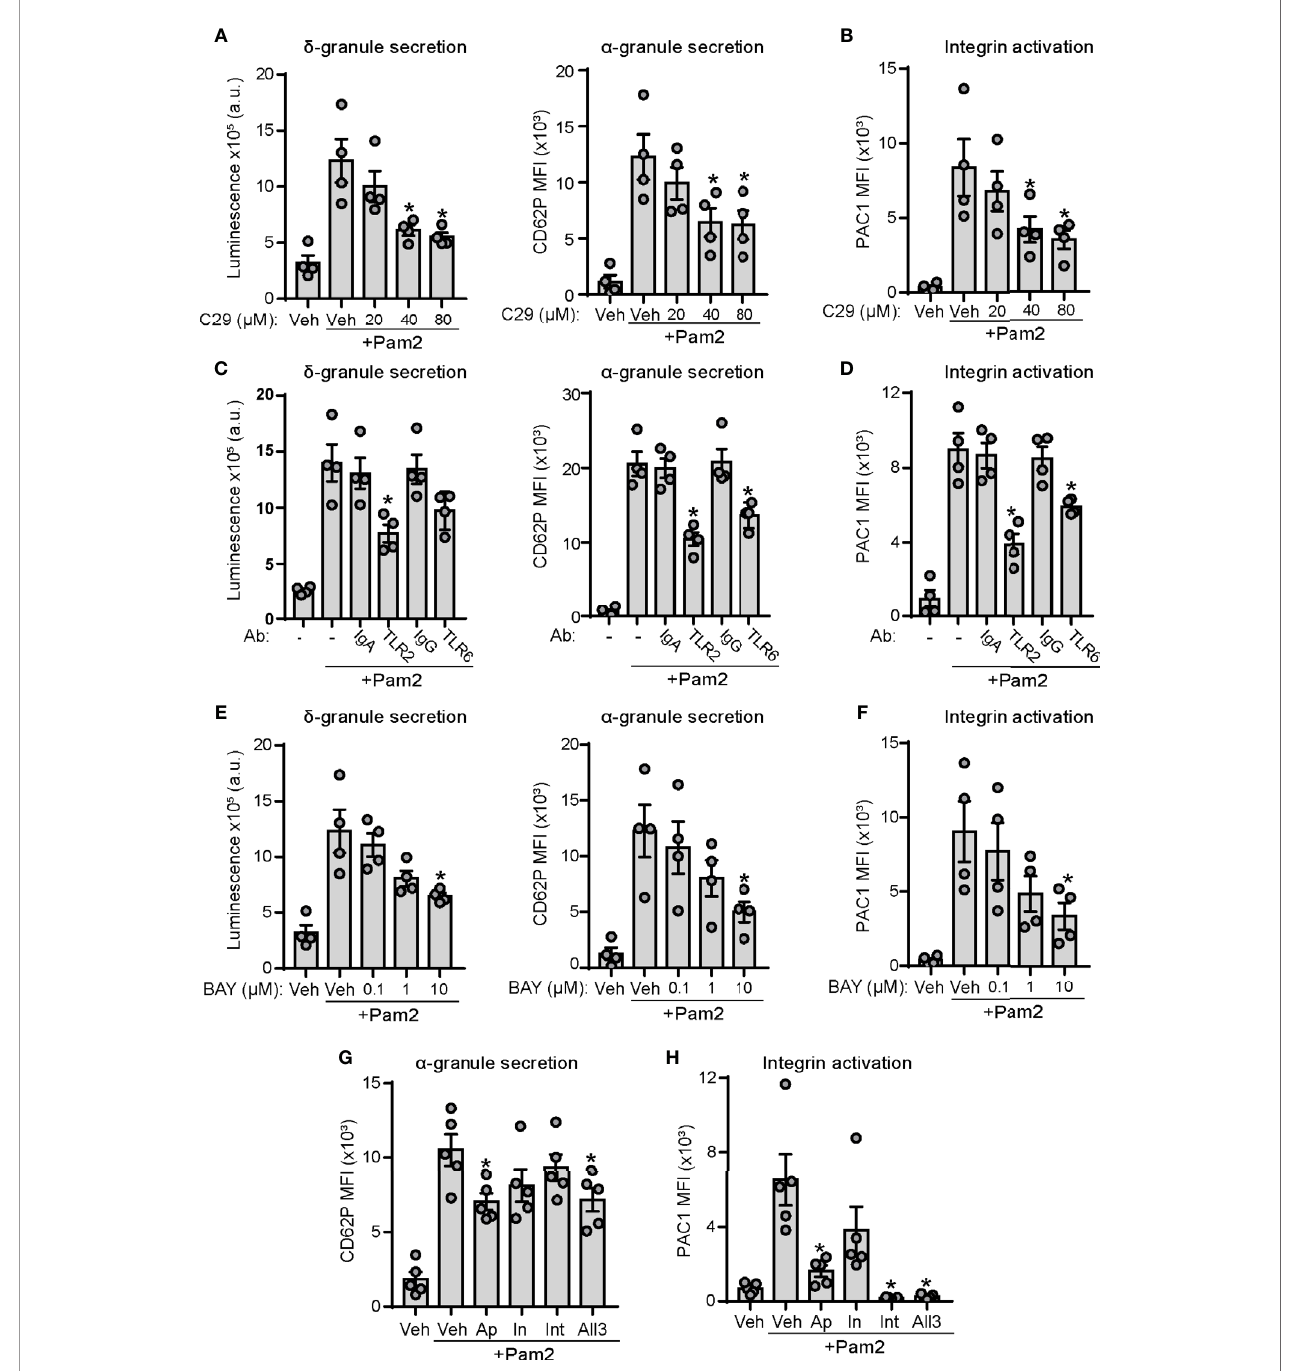
FIGURE 3 | TLR2/TLR6/NF- k B axis and an ADP-positive feedback loop play a role in Pam2CSK4-induced platelet function. (A – H) Washed human platelets were preincubated with the indicated blocking antibodies (25 µg/ml; 30 min), inhibitors or vehicle (10 min) at 37°C before activation with Pam2CSK4 (10µg/ml) and analysis of platelet granule secretion and integrin activation. (A, C, E) Platelets (2×10 8 /ml) were incubated with a luciferin luciferase reagent to measure ATP release and dense granule secretion. Data are expressed as raw mean luminescence (a.u.); n=4 experiments. (B, D, F – H) Platelets (5×10 7 /ml) were pre-treated and activated as above in the presence of fl uorophore-conjugated antibodies against P-selectin (CD62P-APC) or the activated conformation of human integrin a IIb b 3 (PAC1-FITC) and subsequent analysis by fl ow cytometry; n=4-5 experiments. Data are presented as total mean fl uorescence intensity (MFI). * indicates statistical signi fi cance (p<0.05) compared to Pam2CSK4 (- or Veh). BAY indicates BAY11-7082, a NF- k B inhibitor; Ap, 2 U/ml apyrase; In, 10 m M indomethacin; Int, 20 m g/ml integrilin. All 3 indicates combination of apyrase, indomethacin and integrilin at the doses previously indicated. Error bars indicate standard error of the mean